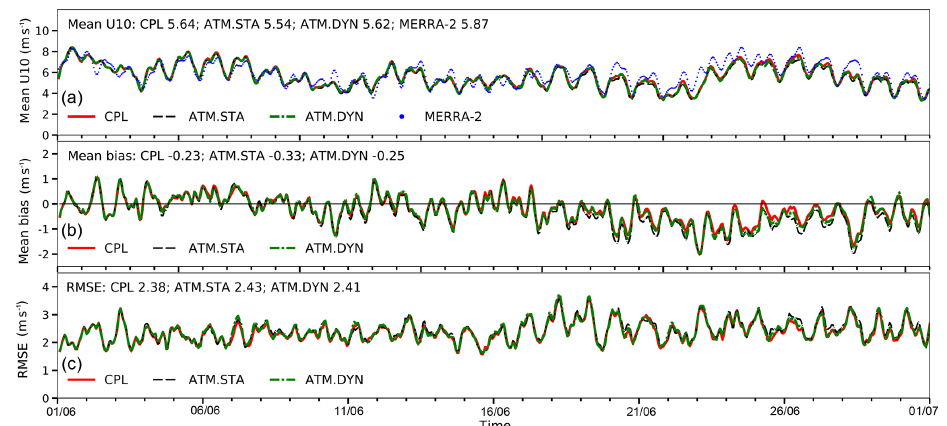
Figure 13. The magnitude of the 10m wind obtained in CPL, ATM.STA, and ATM.DYN in comparison with MERRA-2. Panel (a) shows the mean 10m wind; (b) shows the mean bias; (c) shows the RMSE. Only the hourly surface wind fields over the sea are shown to validate the coupled